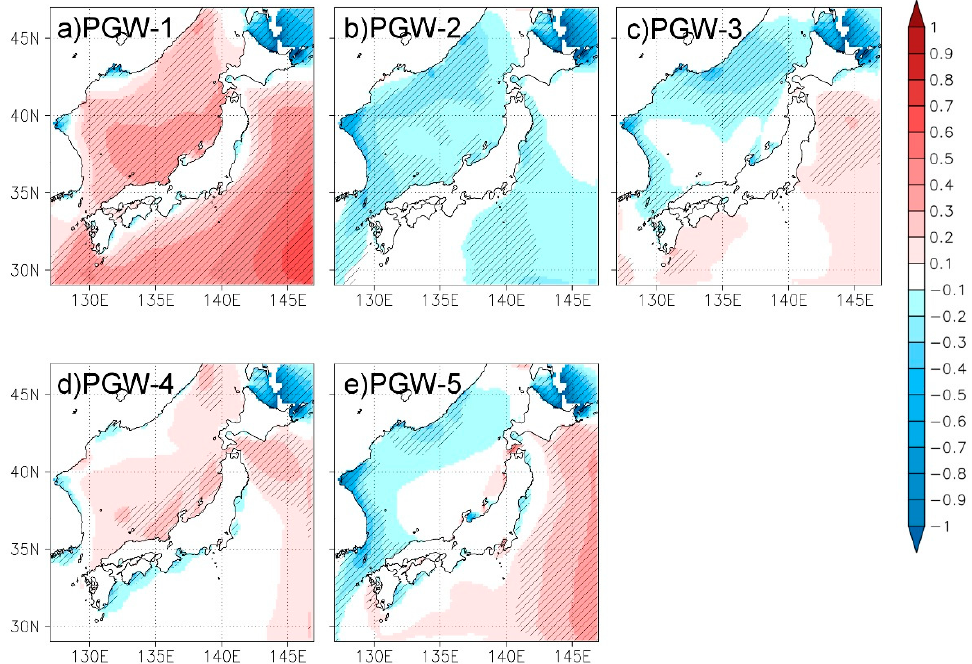
Figure 9. ( a )–( e ) Future variations of T m in each PGW simulation. Areas with statistically significant variation are indicated by hatching. Unit of color bar is sec.